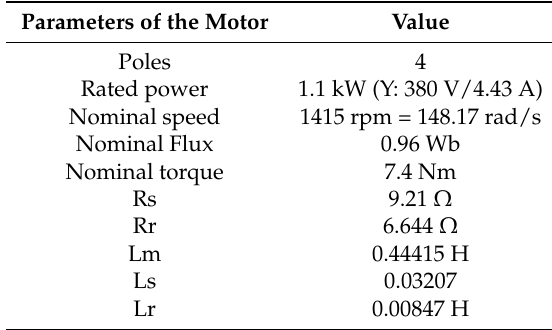
Table 3. Parameters of the induction motors